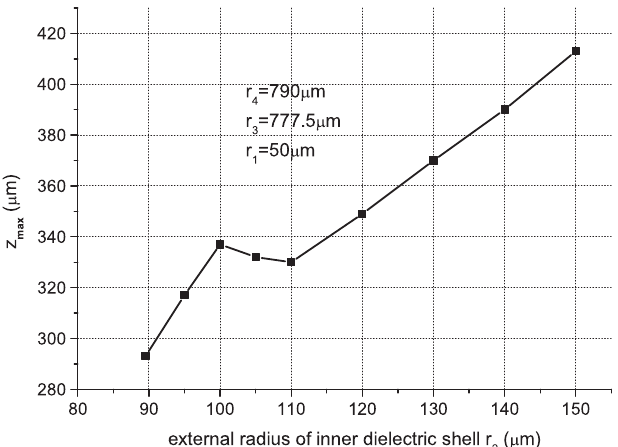
FIG. 12. The location (from drive bunch center) of the first maximum of the accelerating field versus the thickness of the inner radius of the outer dielectric shell. The parameters are the same as those in Fig. 11.